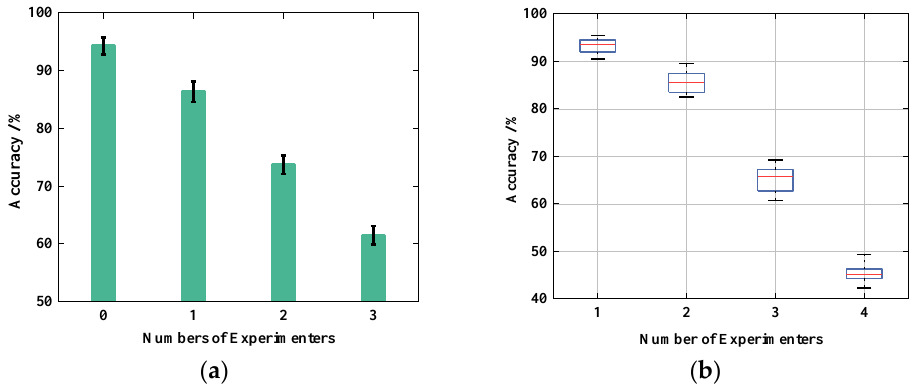
Figure 18. System boundary exploration: ( a ) impact of the number of interferers; ( b ) impact of multiplayer action.